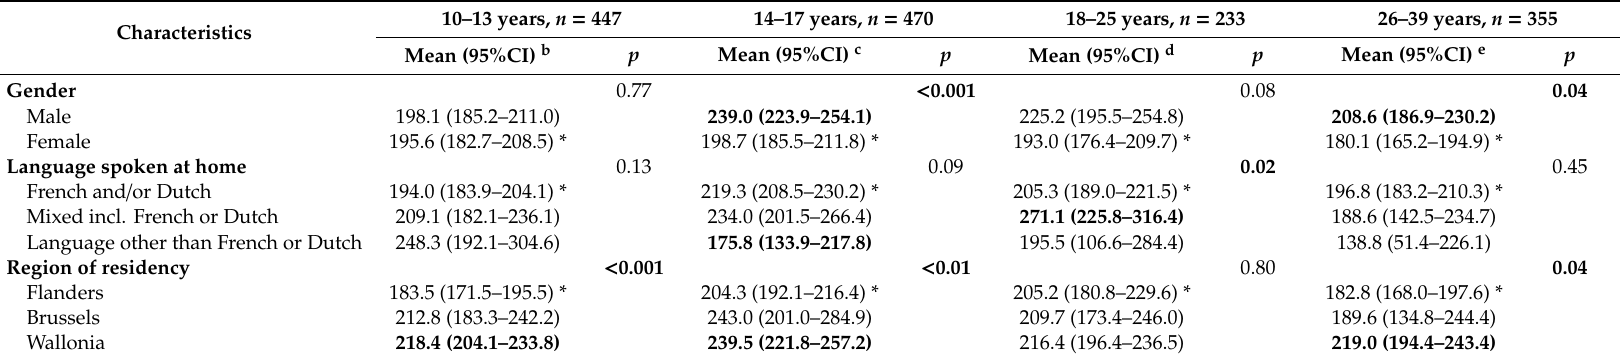
Table 4. Adjusted a mean consumption (g / day) of refined starchy food according to socio-economic and cultural characteristics, and age group. Belgian food consumption survey 2014.